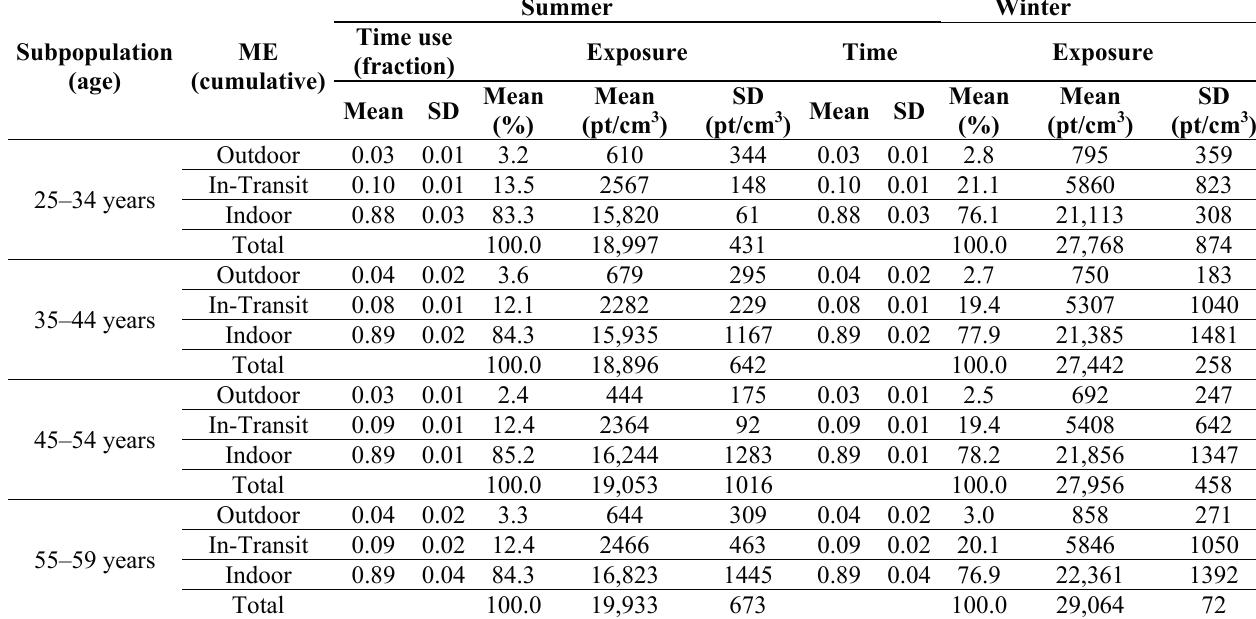
Table 5. Summary of the mean simulated exposures, segregated for cumulative MEs and seasons. Results are shown for age-stratified